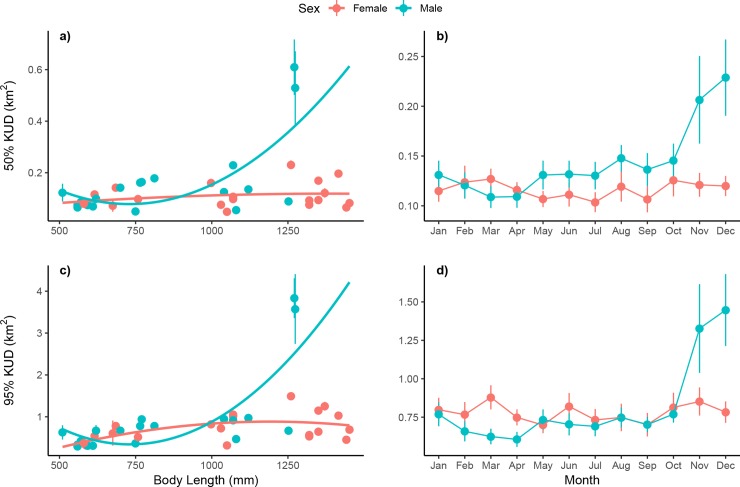
Biological and temporal effects on space use of acoustically tagged blacktip reef sharks at Orpheus Island.(a-b) Effects of size (STL [mm]) and month on core space use (50% KUD) of 40 blacktip reef sharks at Orpheus Island (females: red; males: blue). (c-d) Effects of size and month on extent of space use (95% KUD). Panels include mean and standard error.